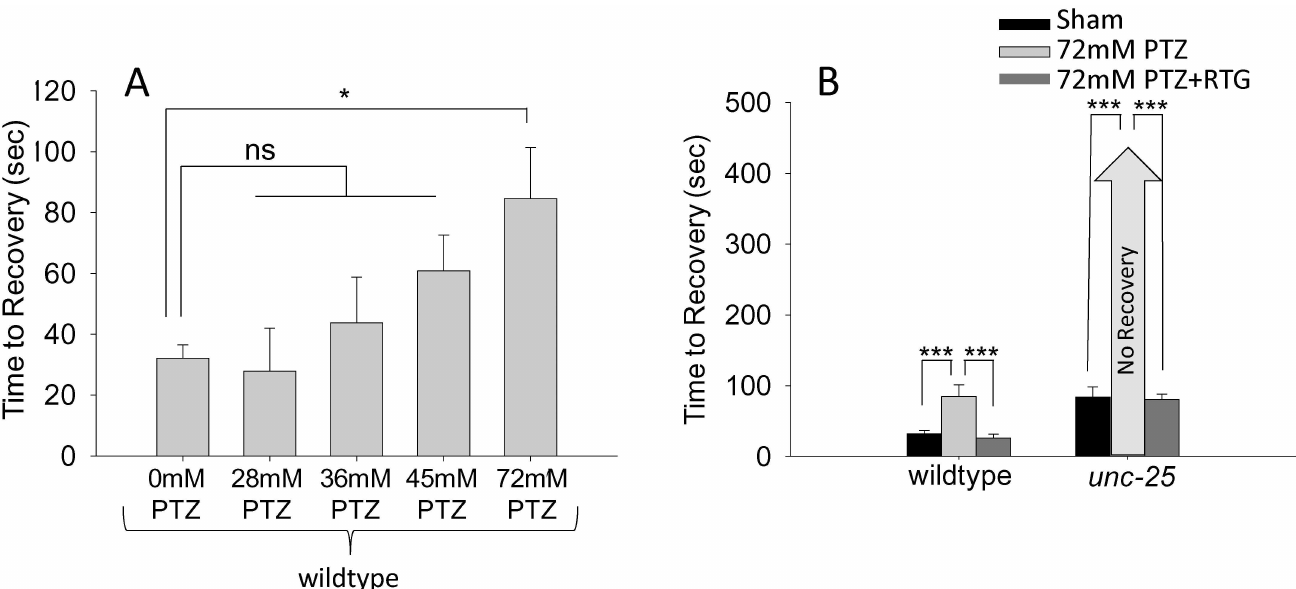
Fig 4. The GABA receptor antagonist PTZ increases recovery time following electroshock. (A) Electric shock recovery times for wild-type animals treated with varying doses of PTZ. (B) 72 mM PTZ extended recovery time of wild-type C . elegans and enhanced deficits in recovery of unc-25 mutants. Both genotypes showed improved recovery when exposed to a cocktail of 72 mM PTZ + 1 mM RTG. Error bars represent standard error of the mean and significance was determined using Student’s t -test where *** P (cid:20) 0.001 and * P (cid:20) 0.05 ns = not significant and n (cid:21) 15.